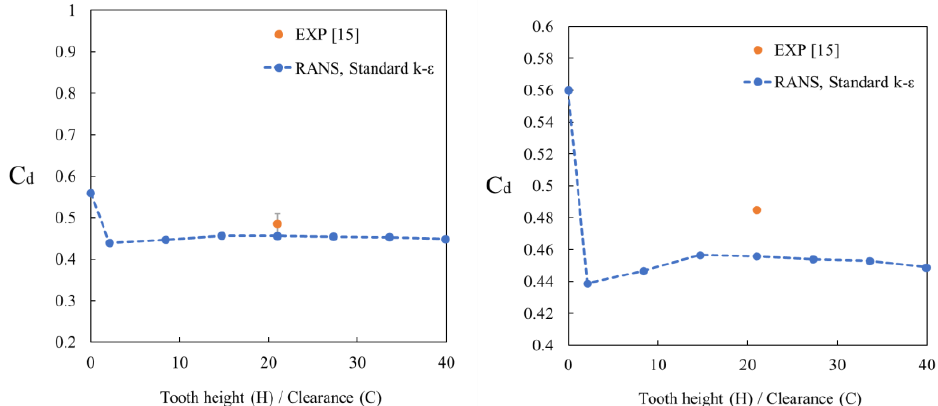
Figure 12. Effect of changing the ratio of the tooth height to the clearance ( H/C ) on the discharge coefficient of the labyrinth seal under a pressure ratio of 2. The x‐axis units on the right‐hand side plot have been expanded. C d —diffusion coefficient.